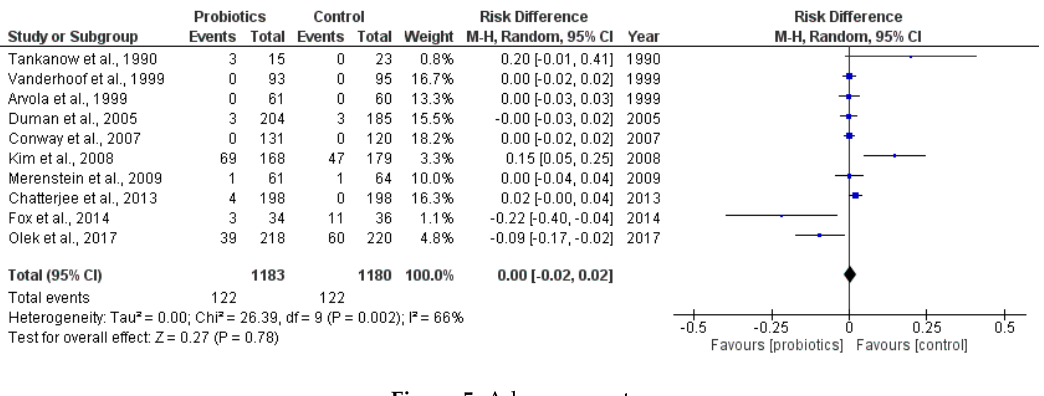
Figure 5. Adverse events.